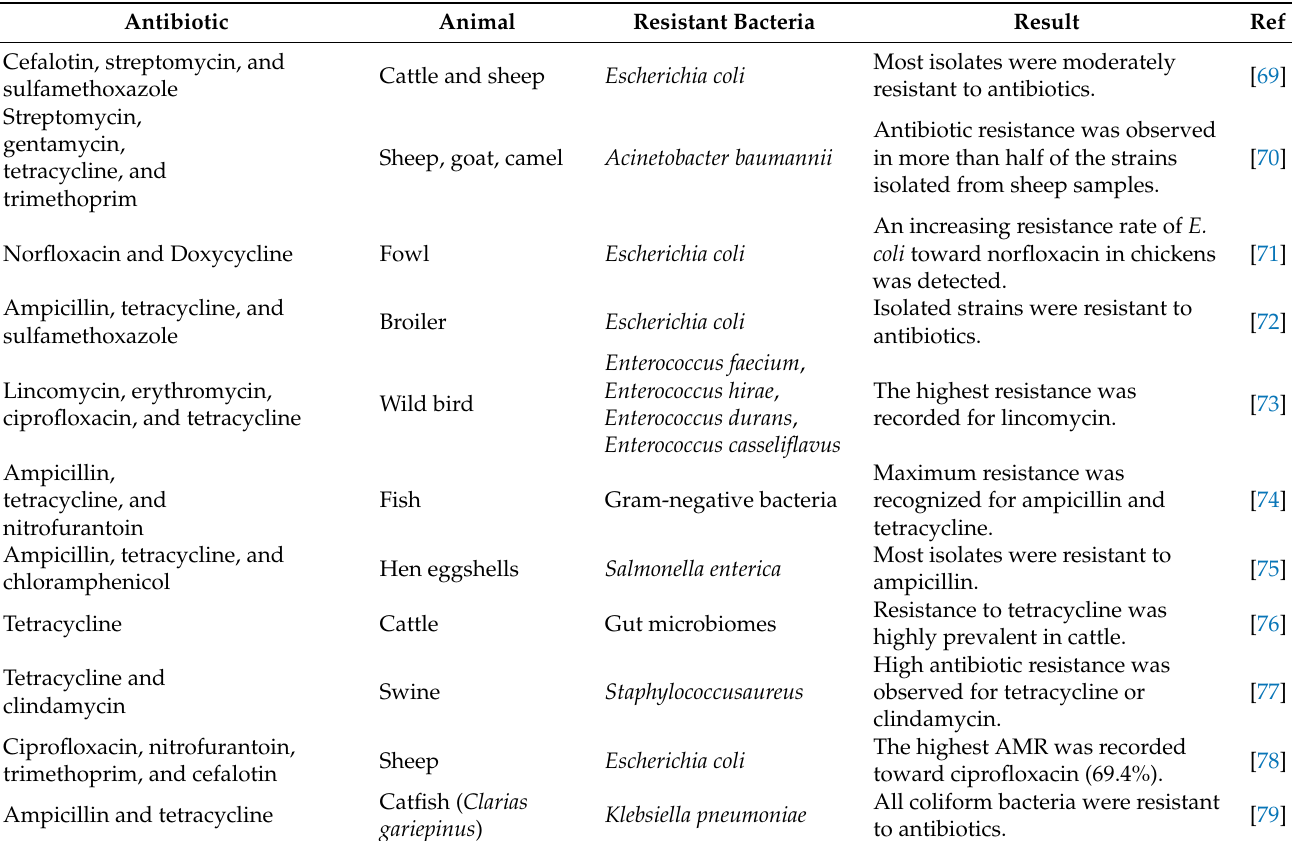
Table 1. Some studies on AMR in animals treated with